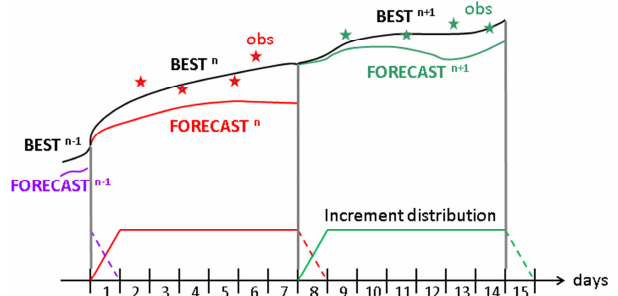
Fig. 4. Schematic representation of the IAU procedure for three consecutive cycles, n − 1, n and n + 1. Following the analysis performed at the end of the forecast (or background) model trajectory (referred to as “FORECAST” first trajectory, with analysis time at the 4 th day of the cycle), the IAU scheme rewinds the model and starts again from the beginning of the assimilation cycle, integrating the 7-day run (referred to as “BEST” second trajectory) with a tendency term added in the model prognostics equations and modulated by an increment distribution function. The time integral of this function equals 1 over the cycle length.